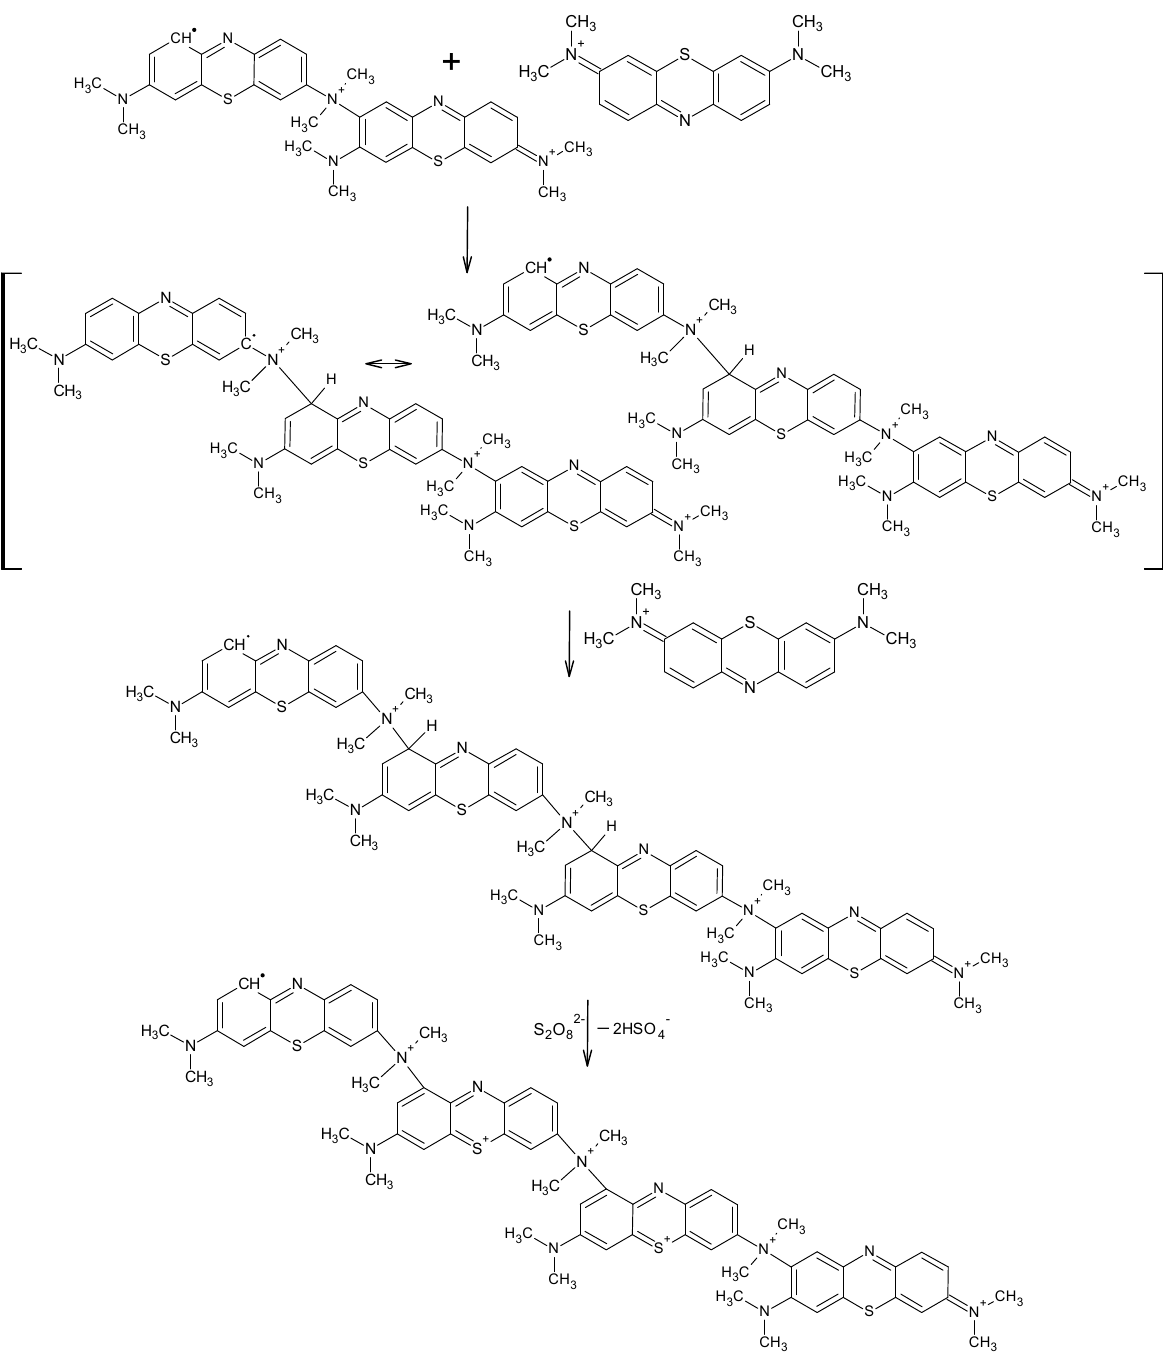
Scheme 2. Mechanism of chain growth under conditions of methylene blue polymerization .